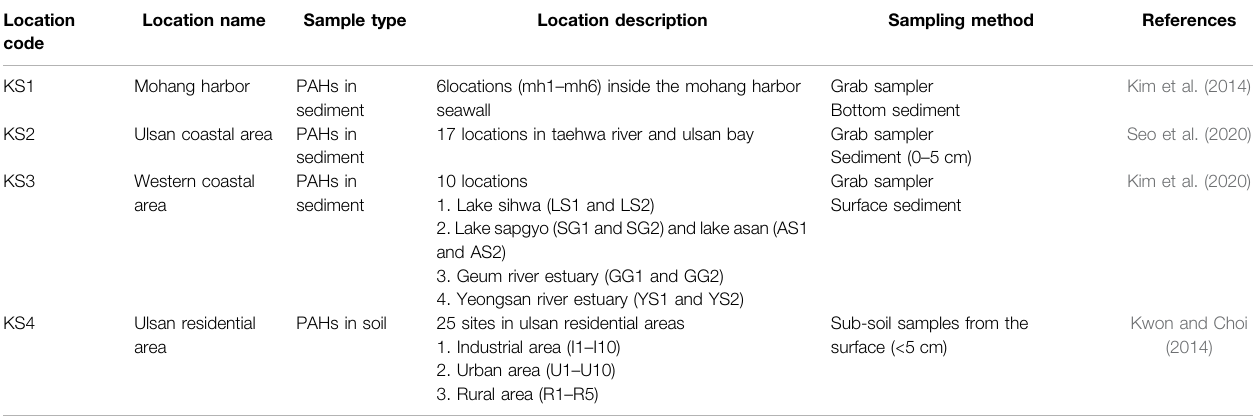
TABLE 1 | Description of the sampling locations, types, and methods.